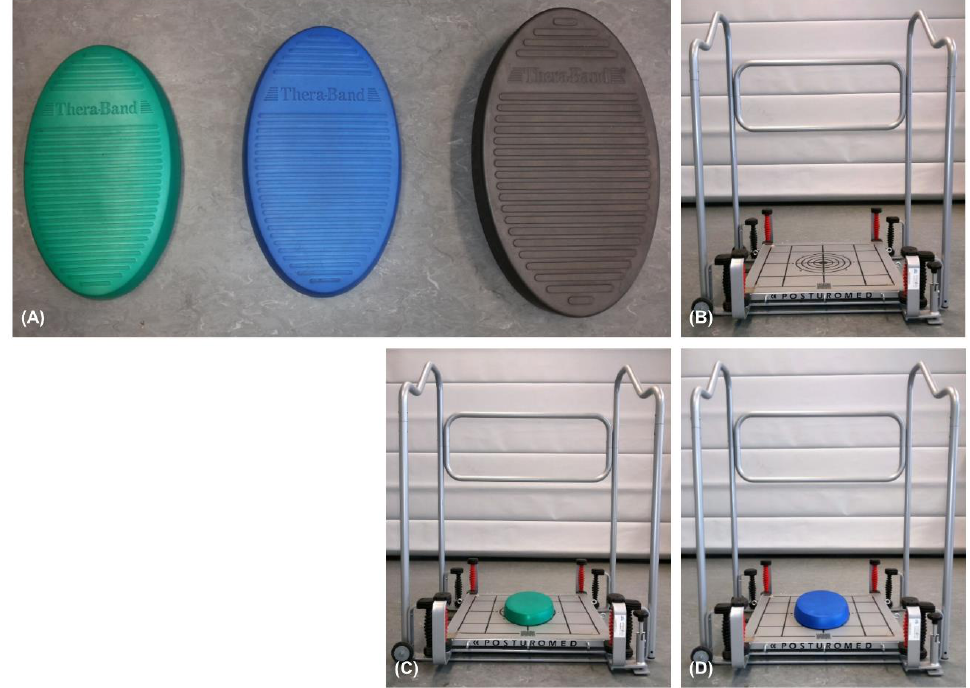
Figure 1. Illustration of the different instability devices used in sensorimotor balance conditions.